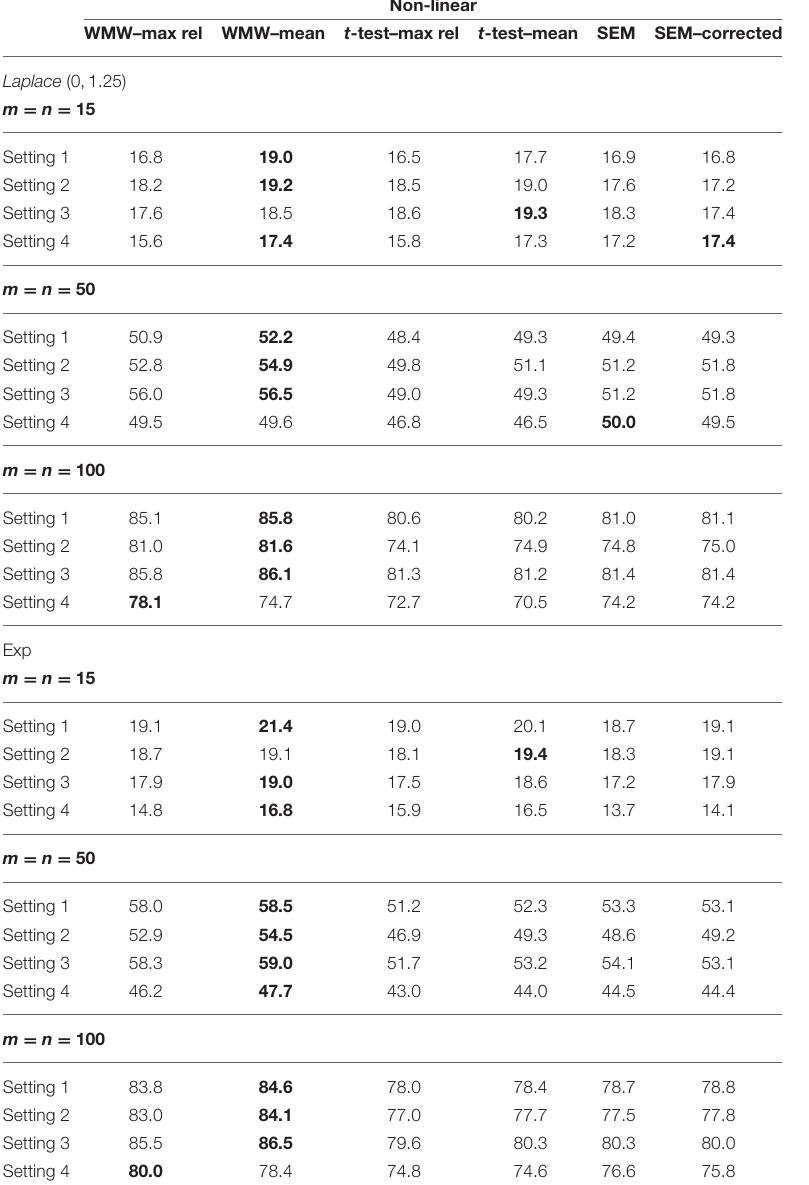
TABLE 4 | Empirical power from the simulation study with the indicators having an overall reliability of 60% and a non-linear relationship with the latent variable. Non-linear